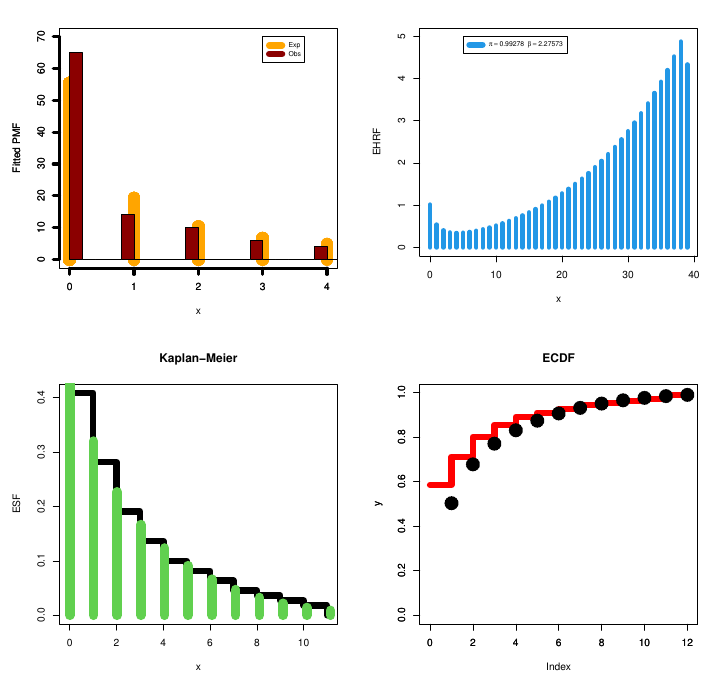
Figure 8 – The fitted PMF, EHRF, ESF and ECDF for the counts of cysts of kidneys